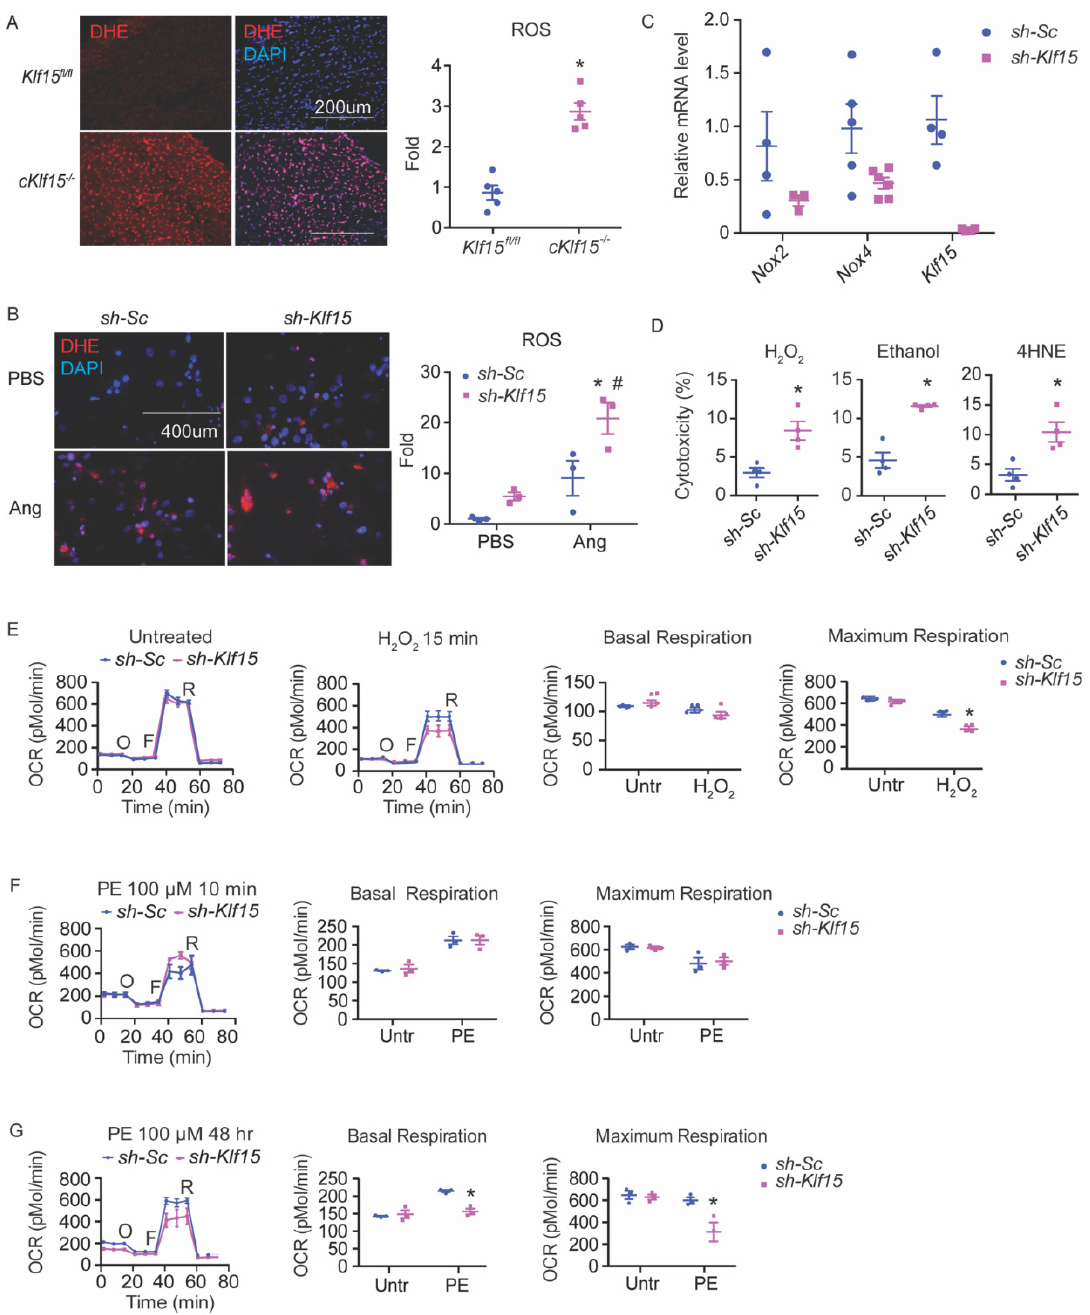
Figure 1. KLF15 deficiency leads to increased susceptibility to ROS in the cardiomyocytes. ( A ) ROS in the hearts of cKlf15 KO and litter mate controls (8–10 weeks old, male) was measured by DHE staining (red) and DAPI (blue), and quantified using NIH Image J ( n = 5, *: p < 0.0001 vs. litter mate controls). ( B ) NRVMs with shRNA knockdown of scrambled RNA ( sh-Sc ) or Klf15 ( sh-Klf15 ). ROS was induced by treatment with Angiotensin II for 24 h and was measured by DHE staining (red) and DAPI (blue), and quantified using NIH Image J ( n = 3, *: p < 0.01 vs. sh-Sc without treatment; #: p < 0.01 vs. sh-Klf15 without treatment). ( C ) qRT-PCR of Nox2 , Nox4, and Klf15 in NRVM with sh-Sc or sh-Klf15 ( n = 3–6). ( D ) NRVMs with shRNA knockdown of scrambled RNA ( sh-Sc ) or Klf15 ( sh-K15 ) were subjected to different stimuli. Percentage of cytotoxicity derived from LDH assay after treatment with each stimulus is shown (ethanol: 100 mM 6 h; H 2 O 2 : 100 μ M 2 h; 4HNE: 10 μ M 8 h) ( n = 4, *: p < 0.05 vs. sh-Sc ). ( E – G ) Mitochondrial ETC function in NRVM assessed by Seahorse Mito Stress test using ( E ) H 2 O 2 for 15 min, ( F ) phenylephrine (PE) for 10 min, ( G ) PE for 48 h, respectively ( n = 3, *: p < 0.05 vs. sh-Sc , two-tailed Student’s t -test). The Holm–Sidak method was used to correct for multiple t -tests with alpha set as 0.05. Data are presented as mean ± SEM.